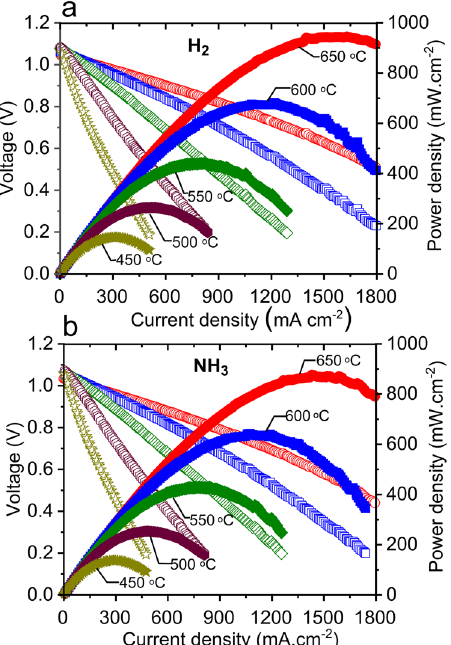
Fig. 3 Fuel cell performance under H 2 and NH 3 fuels. a Fuel-cell polarization under dry H 2 fuel; 3% humidi fi ed air was used as oxidant gas. b Fuel-cell polarization curves under dry cracked NH 3 fuel. Ammonia cracking temperature was 650 °C. The 3% humidi fi ed air was used as oxidant